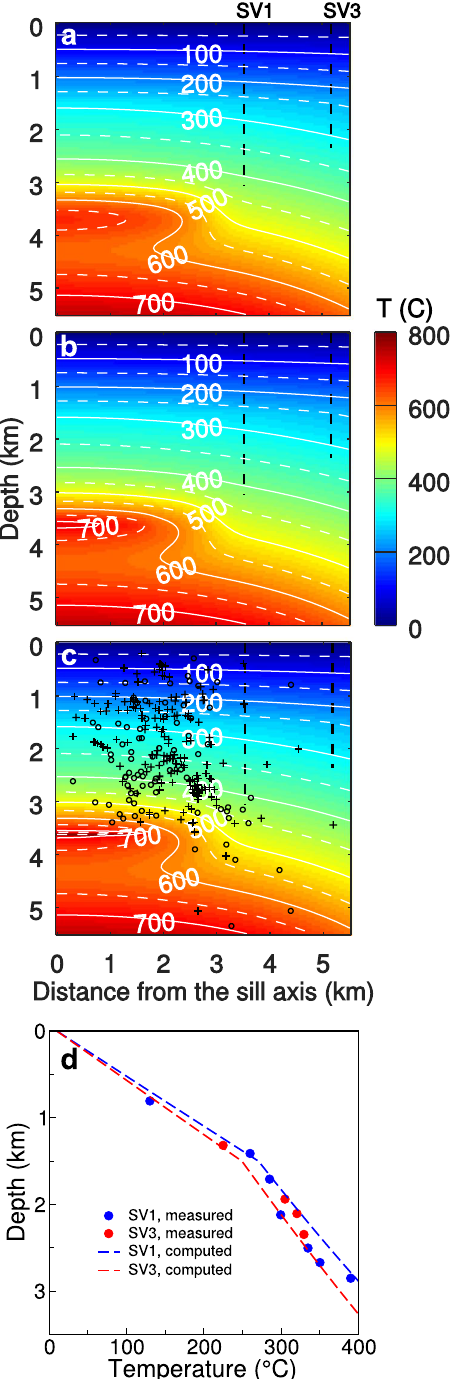
Figure 4. Thermal model. ( a ) Computed thermal section before the 1538 eruption; black dashed lines, SV1 and SV3 boreholes. ( b ) Same as ( a ) but around 1950. ( c ) Same as ( b ) but shortly before 1980; black circles, well located (rms < 0.05) earthquakes from 1982 to 2000 48 ; black pluses, well located earthquakes from 2000 to 2014 48 . ( d ) Dots, SV1 and SV3 temperature data; dashed lines, computed temperature profile at SV1 and SV3 around the half of the 20 th